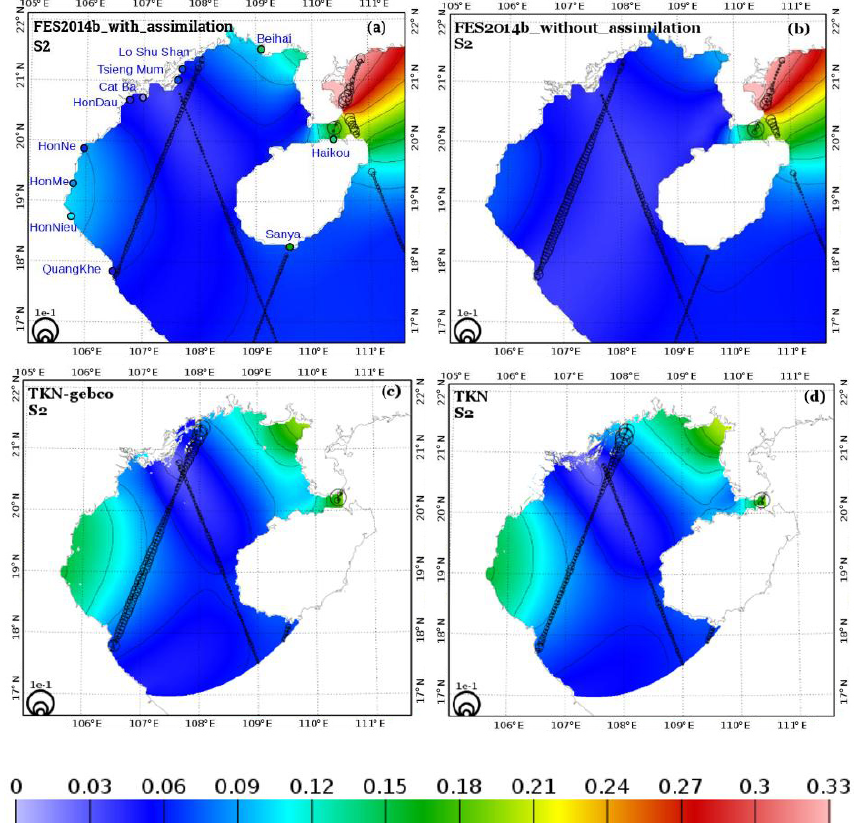
Figure 8. Same as Fig. 5 for S 2